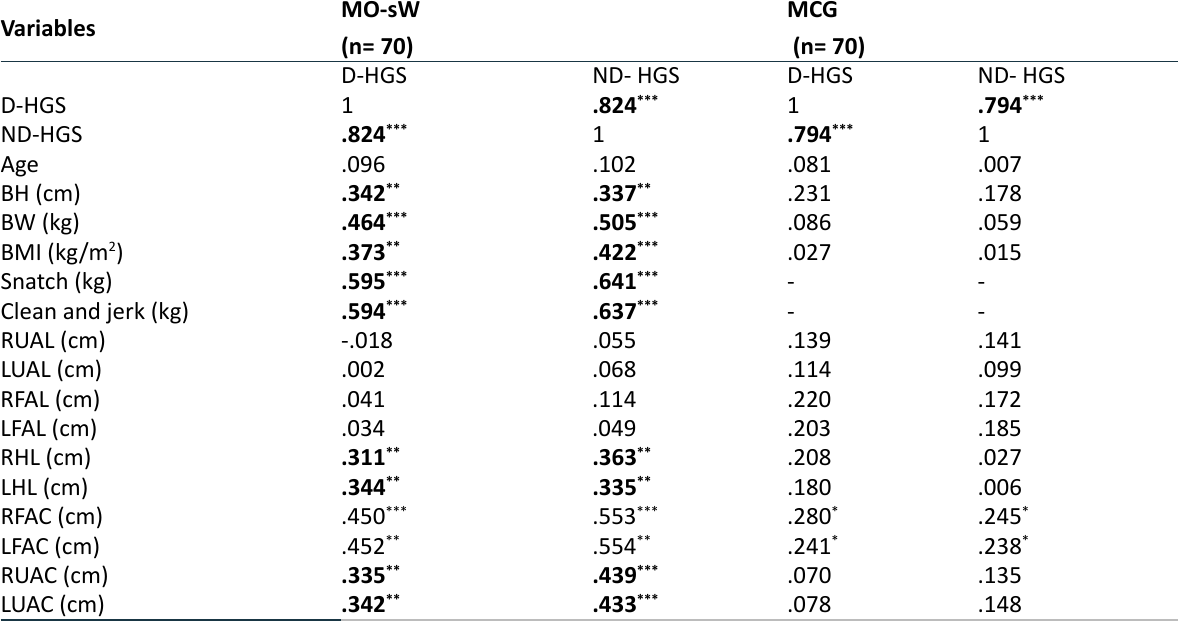
Table 3. The correlations between D-HGS, ND-HGS and some anthropometric values of upper extremity of the groups.